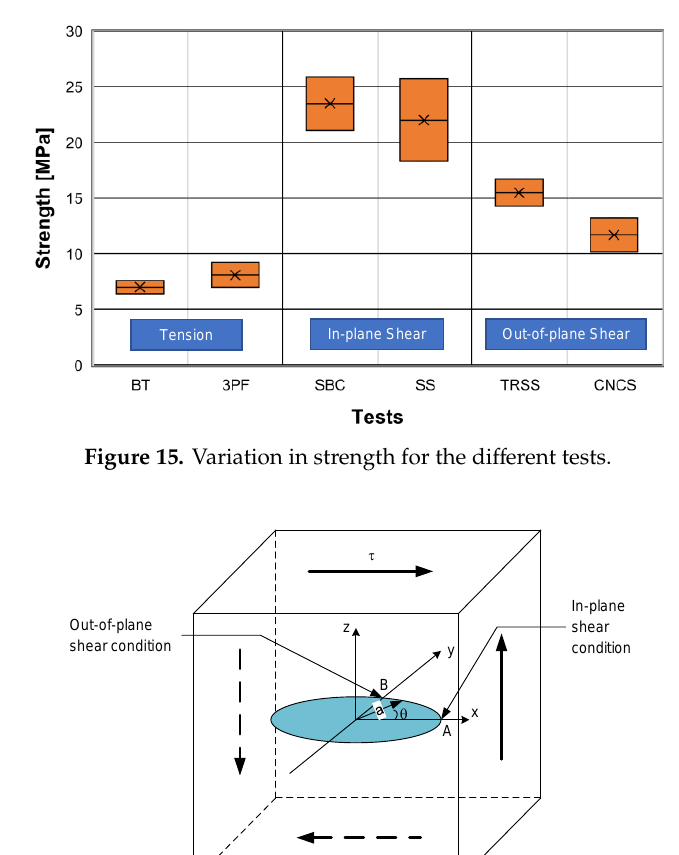
Figure 14. Out-of-plane shear strength versus loading rate: ( a ) torsion test of rectangular section specimens; ( b ) circumferentially notched cylindrical specimen test.